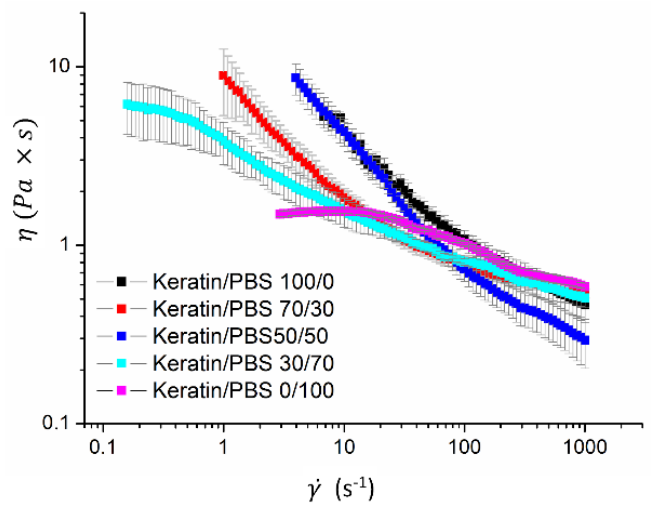
. γ ) of keratin/PBS blend solutions at